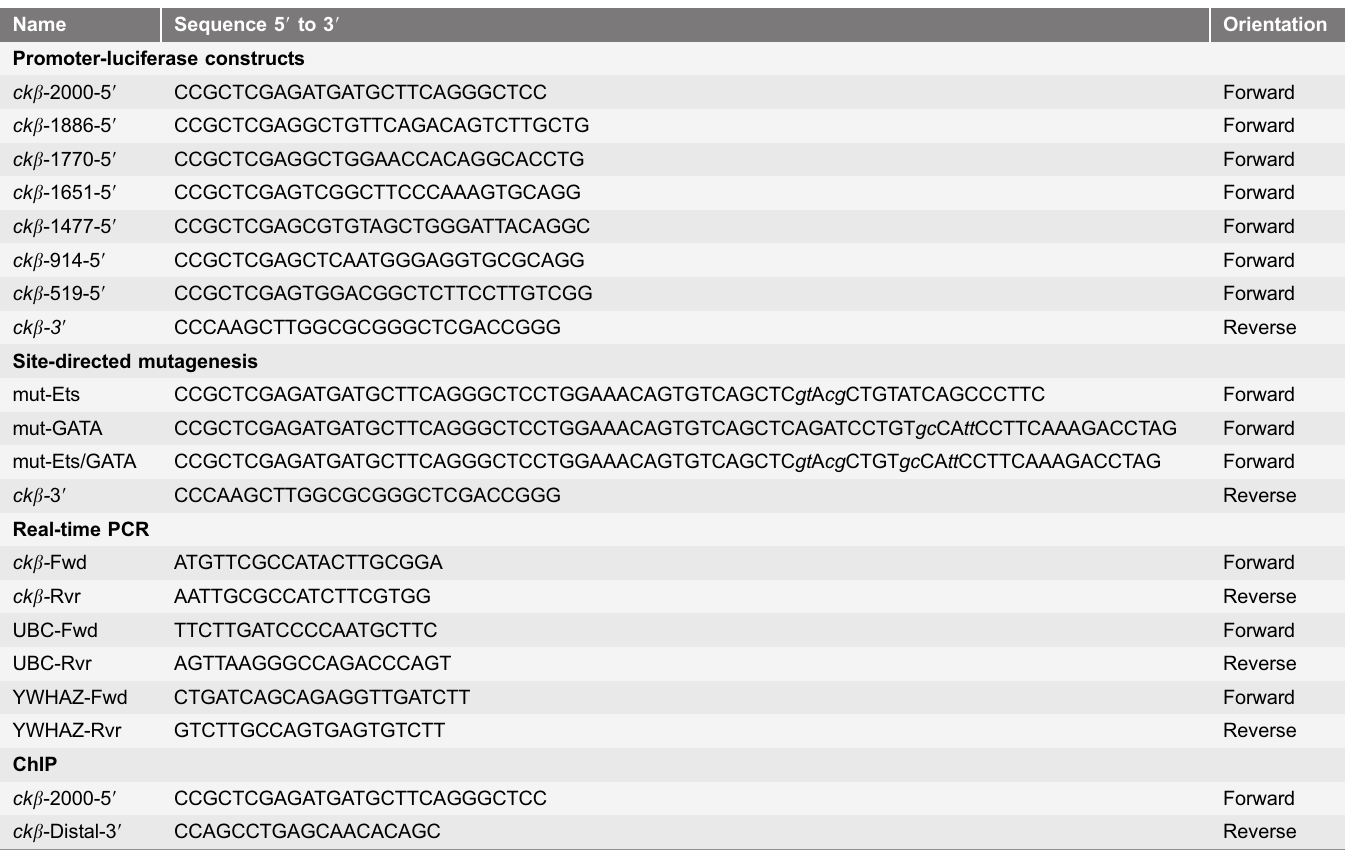
Table 1. Primers used for cloning of promoter-luciferase constructs, PCR-based site-directed mutagenesis, real-time PCR and